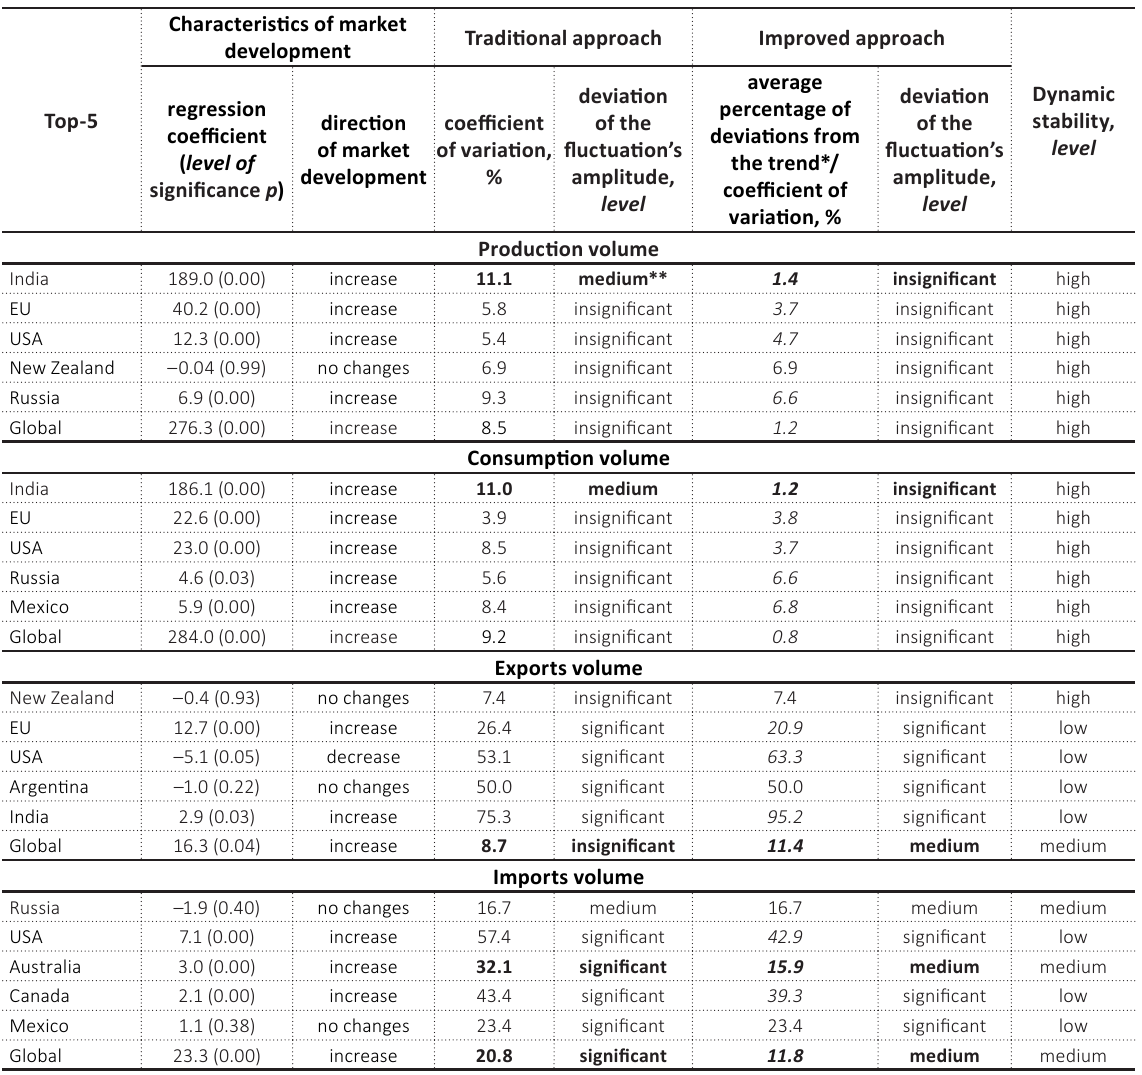
Table 2. Comparison of the traditional and improved approaches to assessing dynamic stability of the growth of the global butter market in 2011−2020